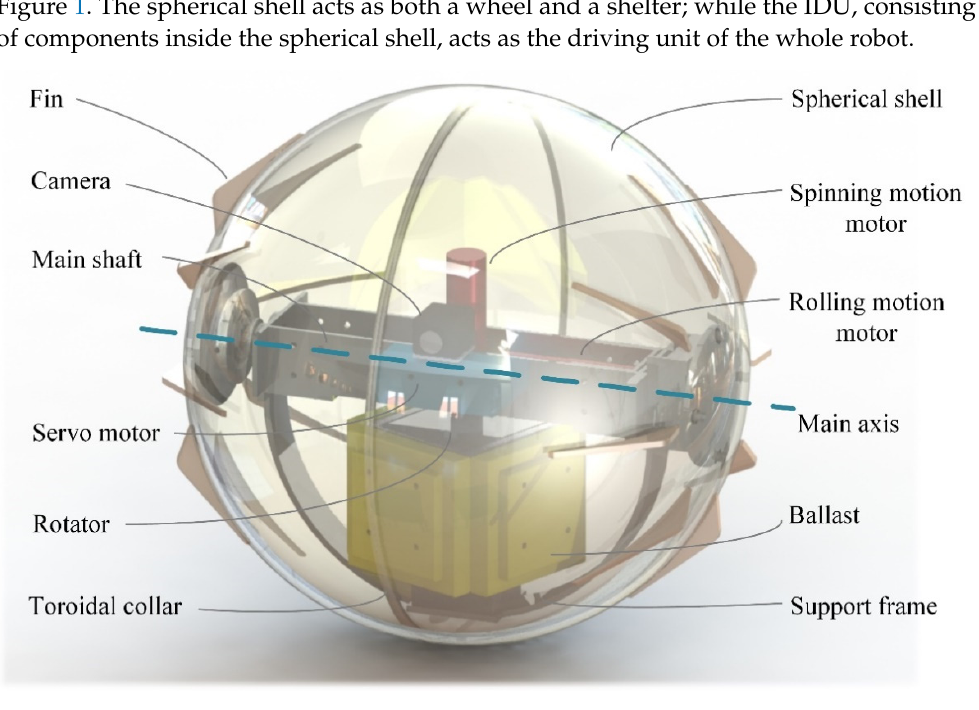
Figure 1. Mechanical structure of the amphibious spherical robot.